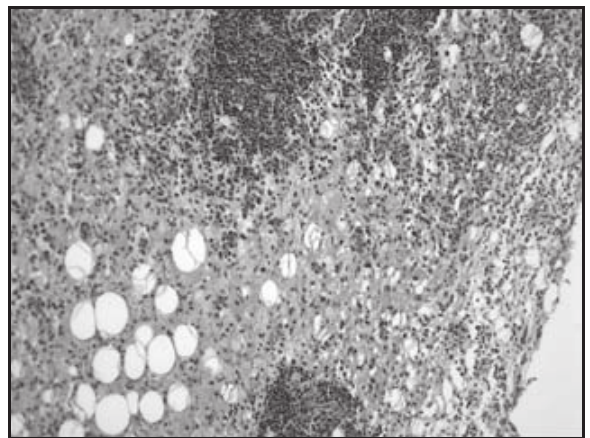
Figure 2 – Chronic inflammatory infiltrate with predominance of histiocytes and sparsely distributed lymphoid aggregates (HE 200x magnification)